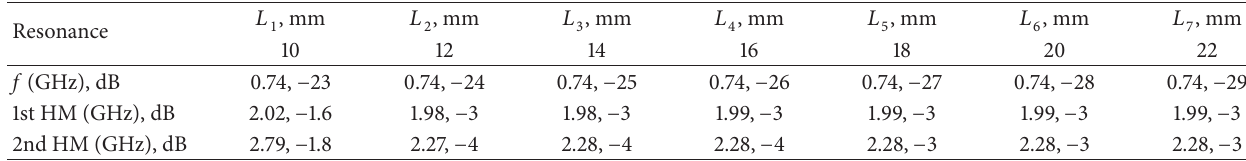
Table 4: Effect of terminal length, 𝐿 , on resonance in Figure 1.